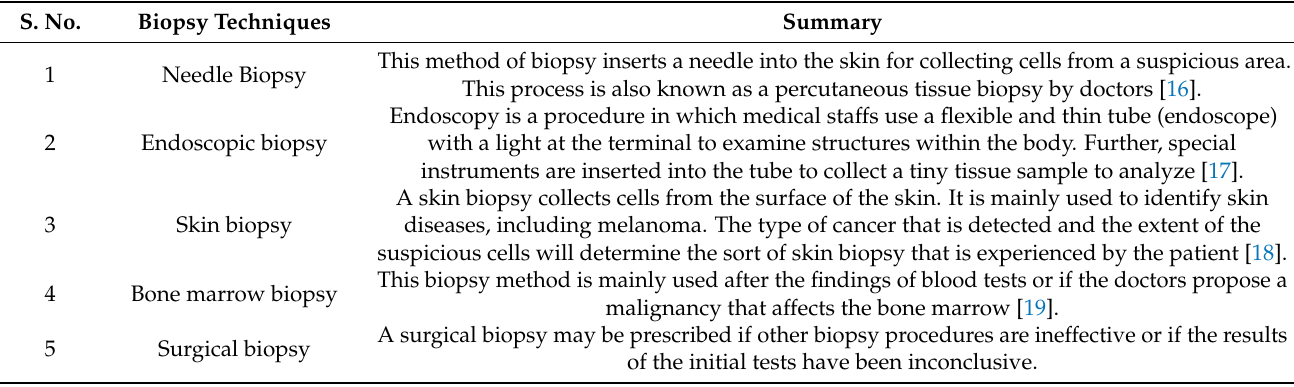
Table 1. Classification of biopsy methods used in the detection of PC.